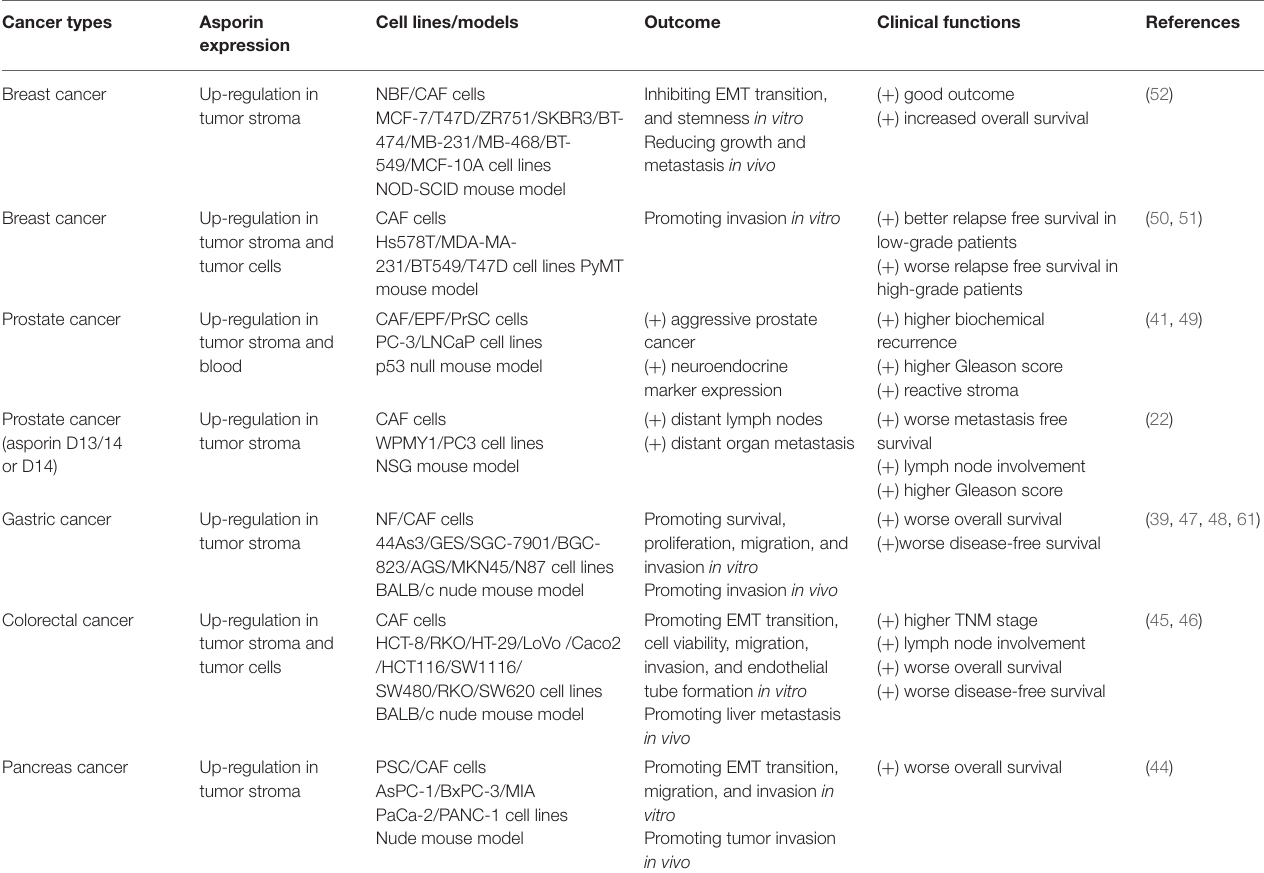
TABLE 1 | Experimental evidence of asporin expression in human